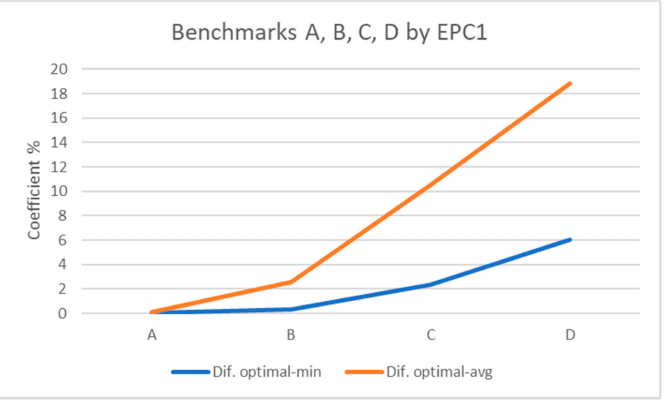
Figure 7. Influence of the complexity of the benchmark.